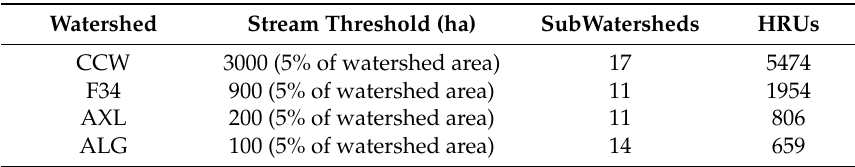
Table 3. Minimum stream threshold values and the resulting subwatersheds and HRUs for each of the study